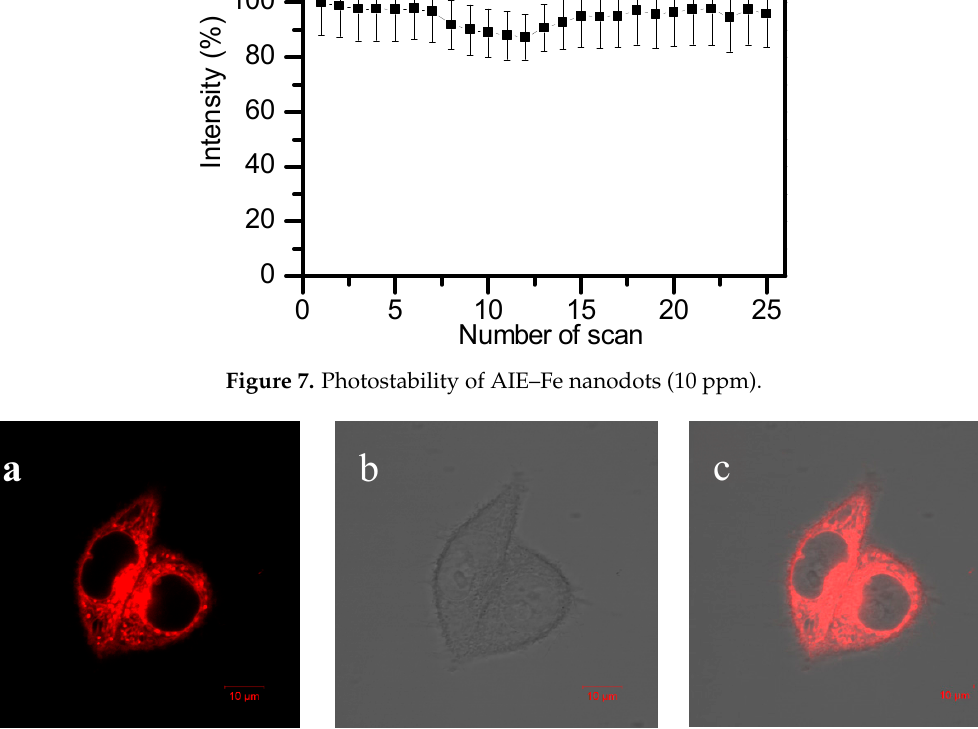
spectrum of 1a. Figure S2, 1H NMR spectrum of 1b. Figure S3, 1H NMR spectrum of TPAS. Figure S4, 13C NMR spectrum of TPAS. Figure S5, HRMS spectrum of TPAS.